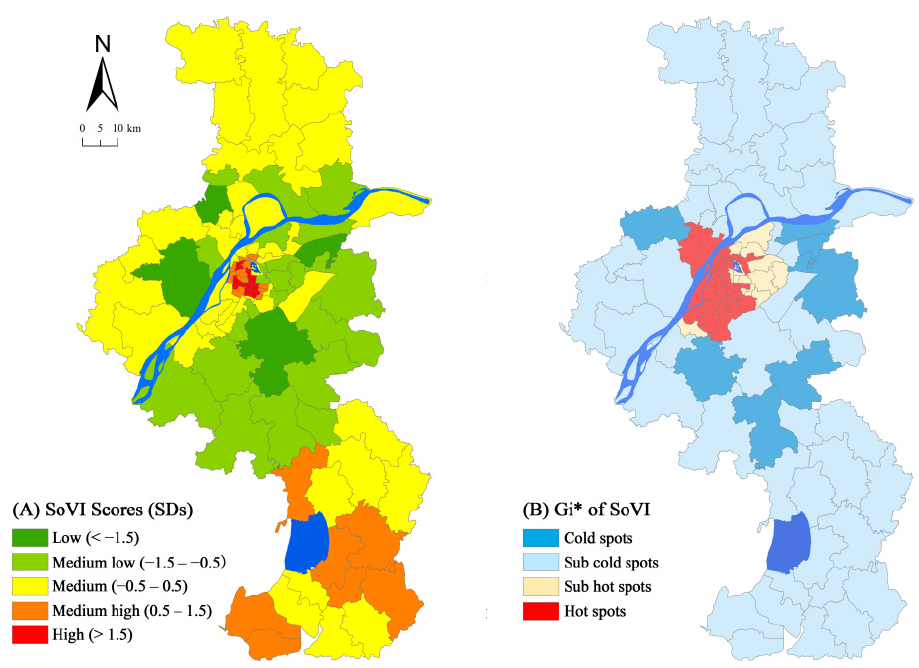
Figure 5. Social vulnerability map ( A ) and hot spot analysis ( B ).